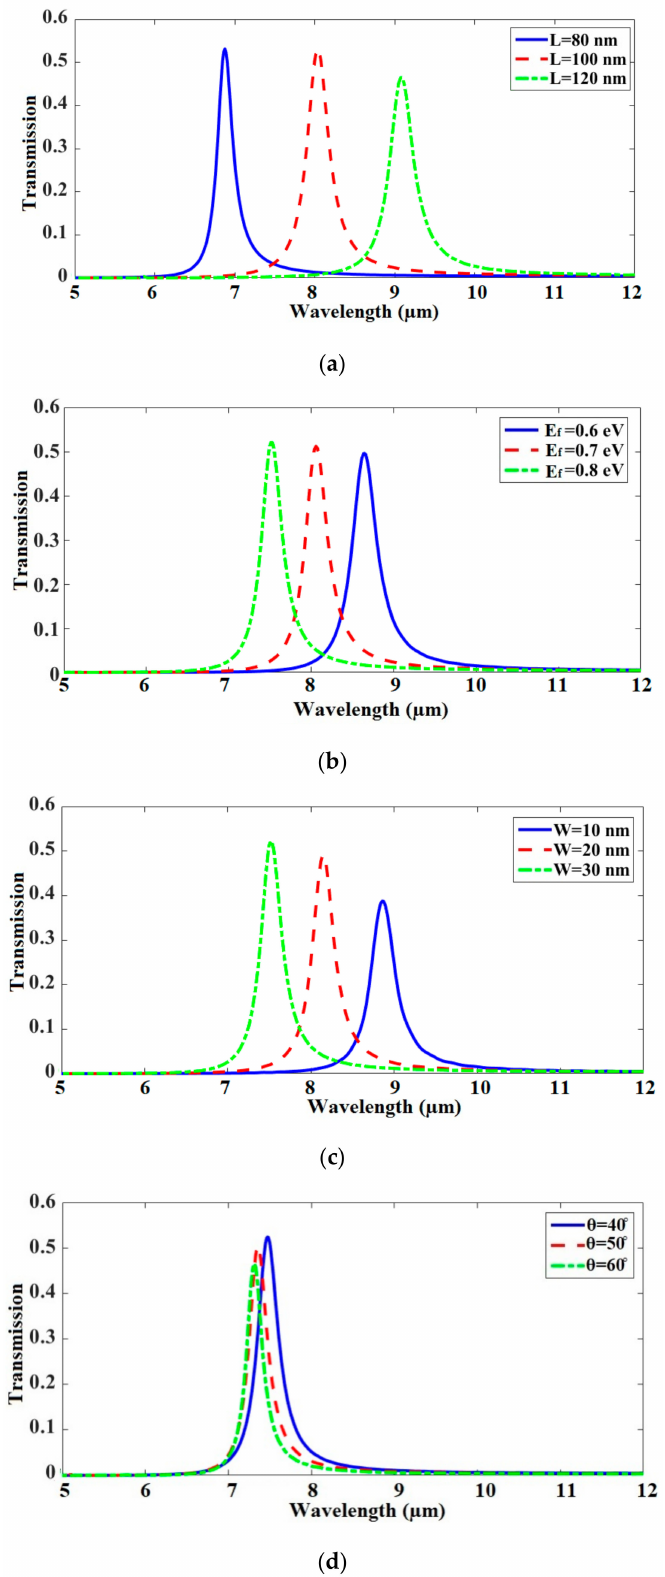
Figure 3. The influence of the alternation of ( a ) resonator length L, ( b ) graphene Fermi energy E f , ( c ) resonator width W, and ( d ) the angle between the ribbon and the horizontal line of the resonator θ , on the transmission spectrum of the proposed structure of Figure